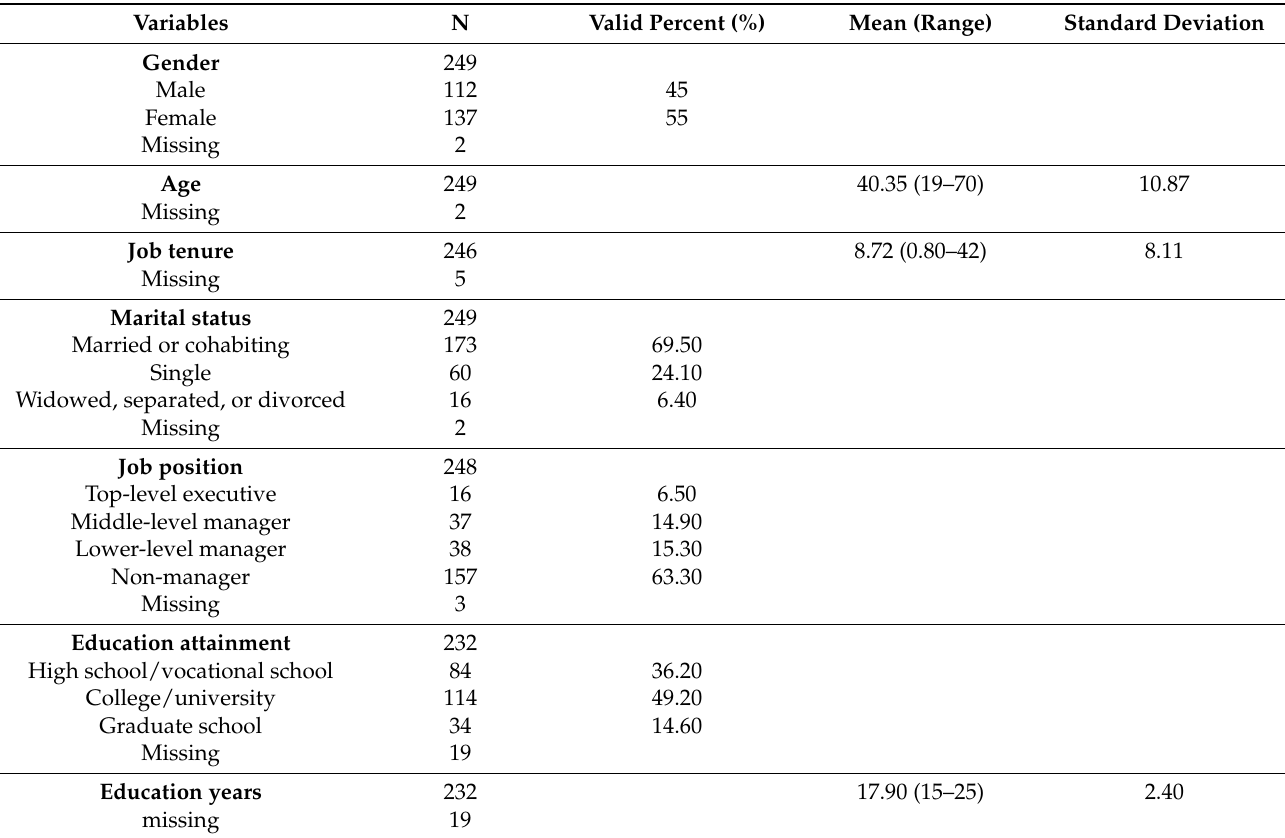
Table 1. The descriptive statistics for the ample (N =